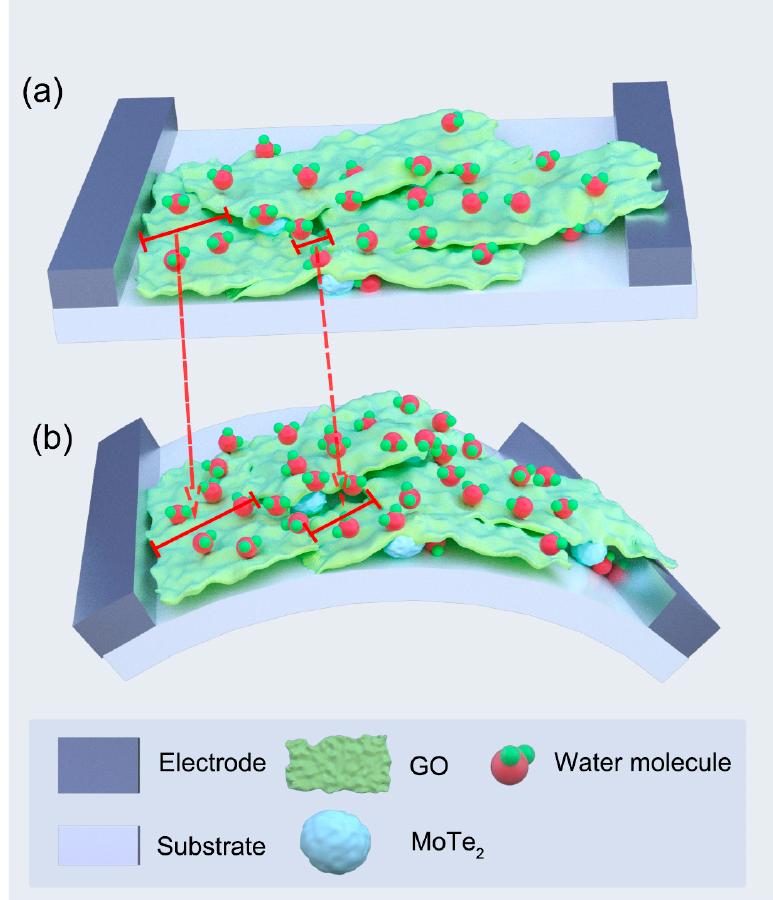
Figure 5. Schematic diagram of the composite film of the sensor under flat ( a ) and bending ( b ) states. To evaluate the accuracy and efficiency of the humidity sensor, the hysteresis char- acteristic is also a significant parameter. The dynamic hysteresis loop curve is shown in Figure 4c. It can be found that the frequency shifts of the humidity sensor in the cycle of increasing humidity and decreasing humidity are approximate at each fixed humidity